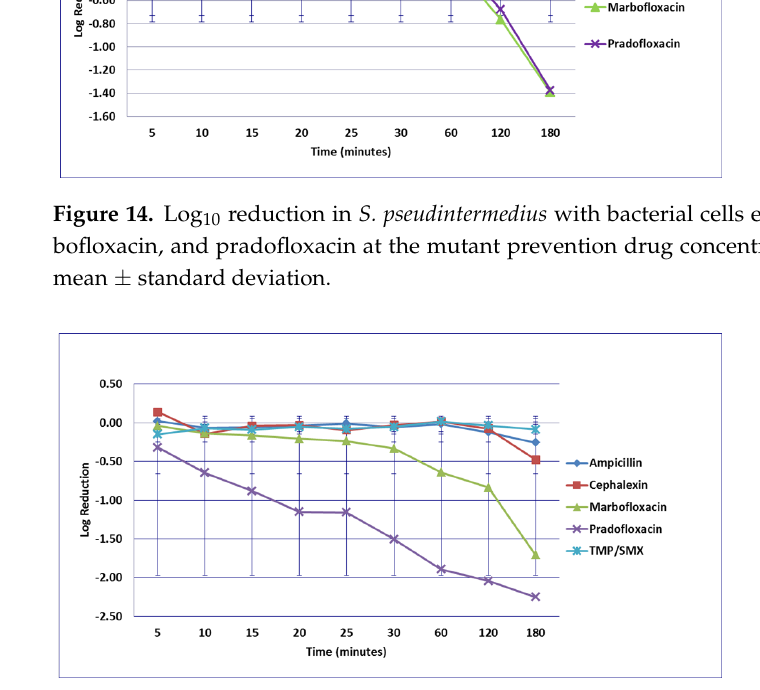
Figure 15. Log 10 reduction in S. pseudintermedius with bacterial cells exposed to ampicillin, cephalexin, marbofloxacin, pradofloxacin, and trimethoprim/sulfamethoxazole at the maximum serum drug concentration. *Pradofloxacin vs. ampicillin at 25, 30, 60, and 120 min, p values from <0.0001 to 0.0045. Pradofloxacin vs. cephalexin at 20, 30, 60, and 120 min, p values from <0.0001 to 0.0394. Pradofloxacin vs. TMP/SMX at 30, 60, 120, and 180 min, p values from <0.0001 to 0.0017. Cephalexin vs. marbofloxacin at 60, 120, and 180 min, p values from 0.0006 to 0.0037. Marbofloxacin vs. TMP/SMX at 60, 120, and 180 min, p values from <0.0001 to 0.0033. Marbofloxacin vs. ampicillin at 60, 120, and 180 min, p values from <0.0001 to 0.0025. Data points present mean ± standard deviation.